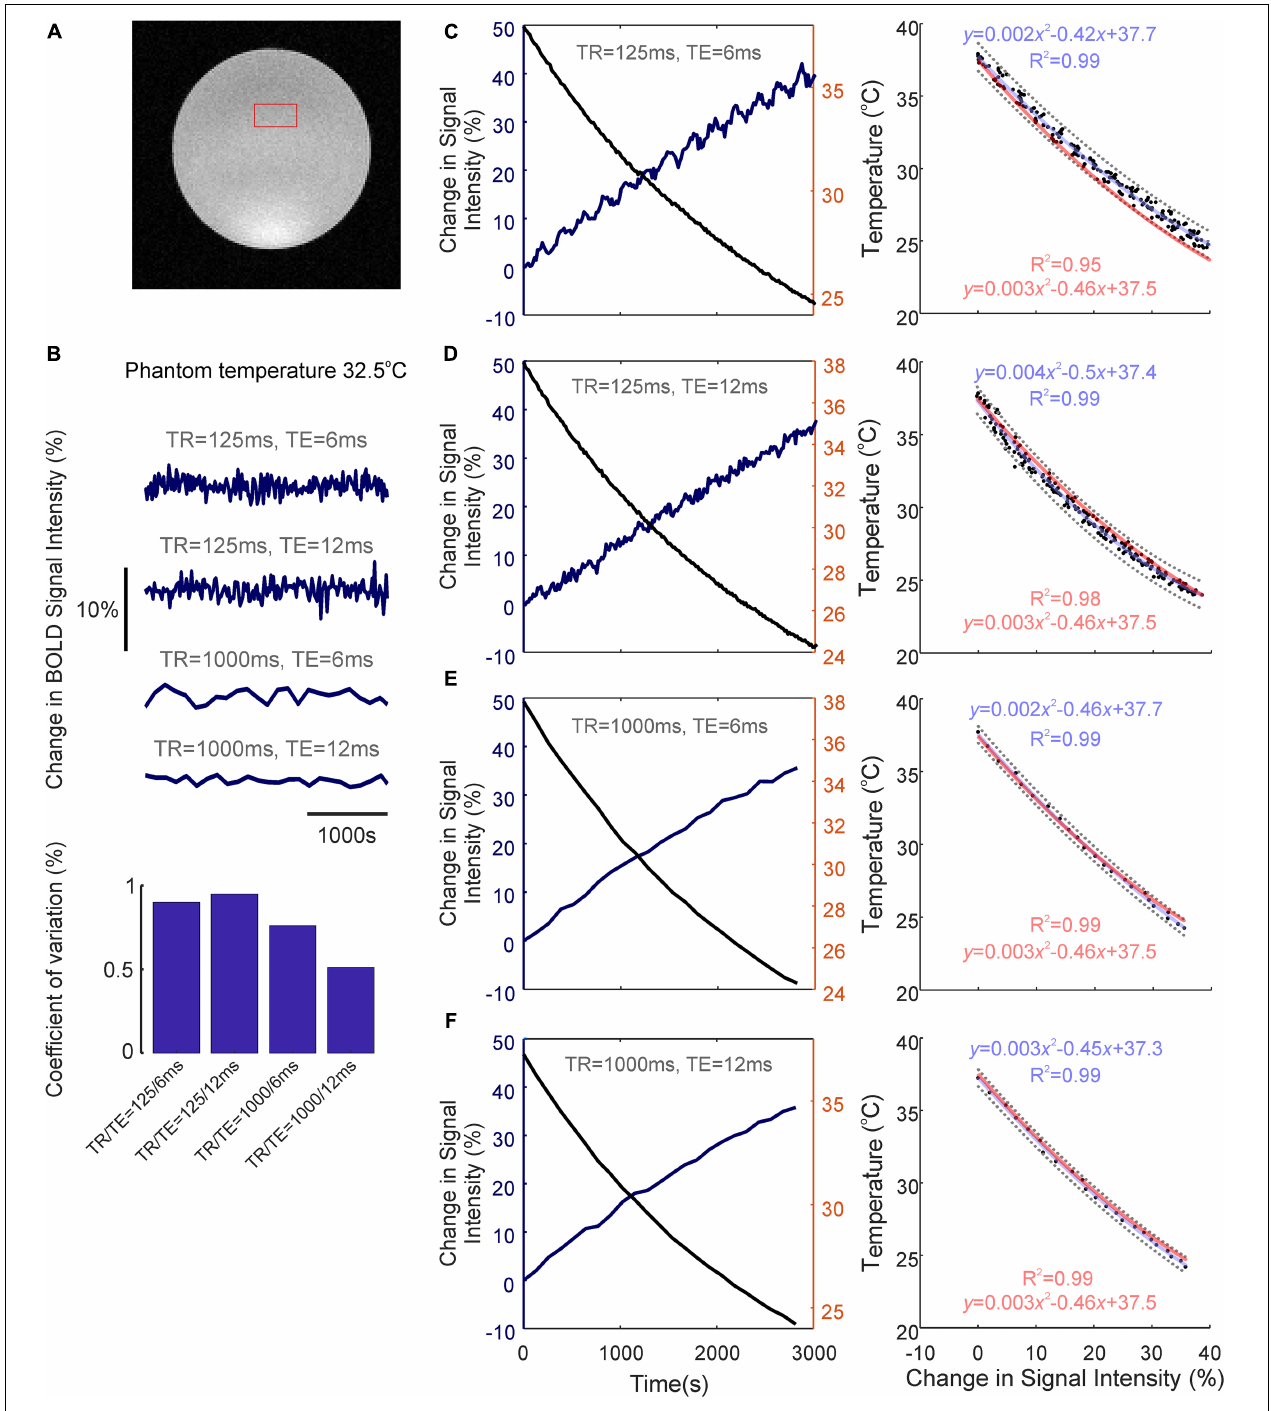
FIGURE 3 | Temperature-dependence of the BOLD fMRI signal. (A) Coronal image of saline-phantom, with inset of example region of interest (ROI) from which fMRI timeseries data was extracted. (B) Confirmation that BOLD signal intensity remains approximately constant at all TR/TE combinations studied during repeated scan acquisitions over 3,000 s with a constant phantom temperature of 32.5 ◦ C (bar graph at bottom illustrates low coefficient of variation in each condition). (C) Left: Percentage change in BOLD signal intensity during phantom-cooling from 38 to 24 ◦ C, TR/TE = 125/6 ms. Right: Associated inverse coupling between BOLD signal intensity and temperature from data shown in left panel. Second order polynomial function fitted using least-squares regression (blue), which provided an excellent fit to the data ( R 2 = 0.99). 95% confidence bounds are shown as dashed gray lines. (D–F) same as in C , but with TR/TE = 125/12 ms, 1,000/6 ms, and 1,000/12 ms, respectively. (C–F) Generalized second-order polynomial functions fitted using least-squares and averaged coefficients from individual regression models in C–F (red) provided comparable fits ( R 2 = 0.95–0.99).